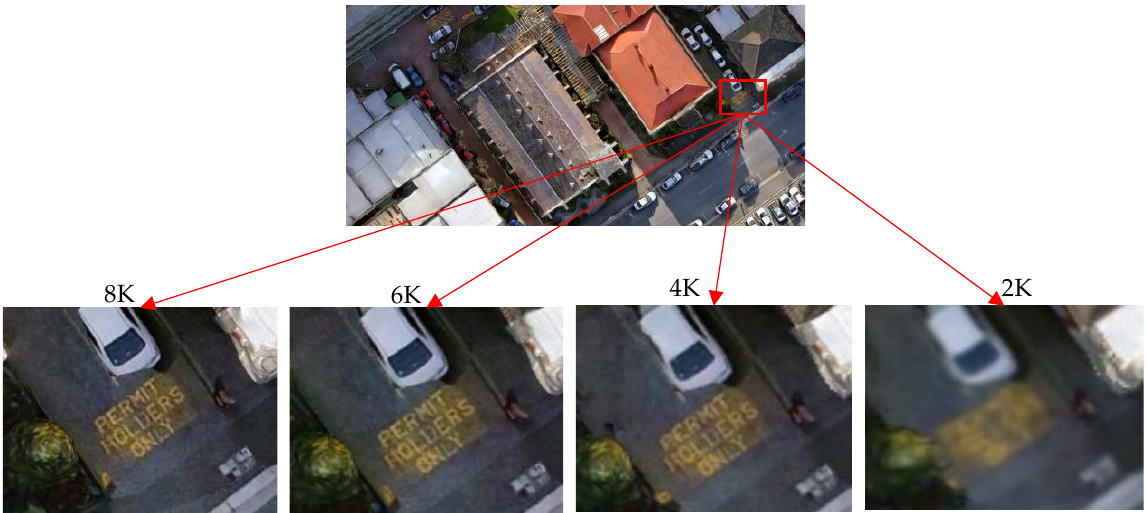
Figure 9. The road mark writing at a garage entrance in the four video resolutions 2K, 4K, 6K, and 8K created orthoimages.